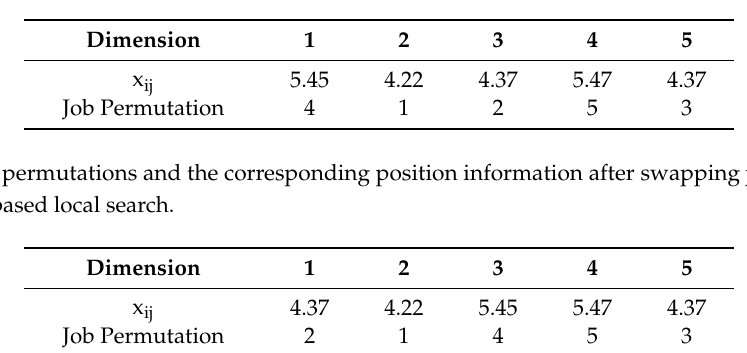
Table 1. Representation of the solution of position information of each particle and the corresponding ROV for the corresponding job permutation.